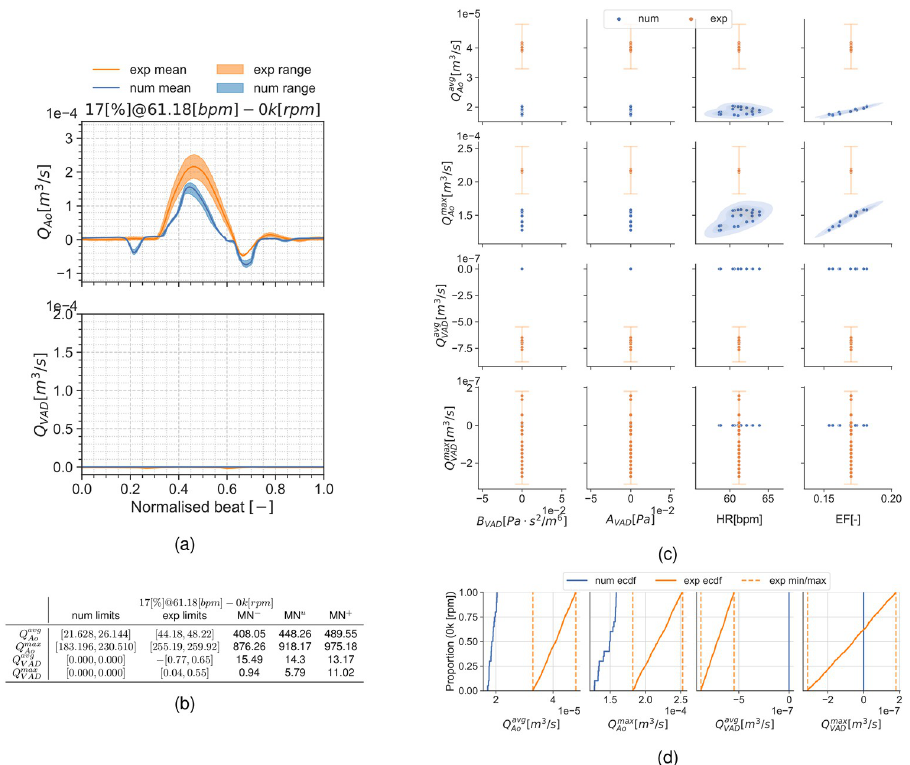
Fig 9. Summary for the condition 17[%]@61.18[ bpm ] and 0 k [ rpm ]. (a): aortic valve and LVAD flows. (b): validation metrics. (c): scatter plot showing the simulation and experimental data. (d): ECDF for the simulation, experimental data limits and the constructed uniform